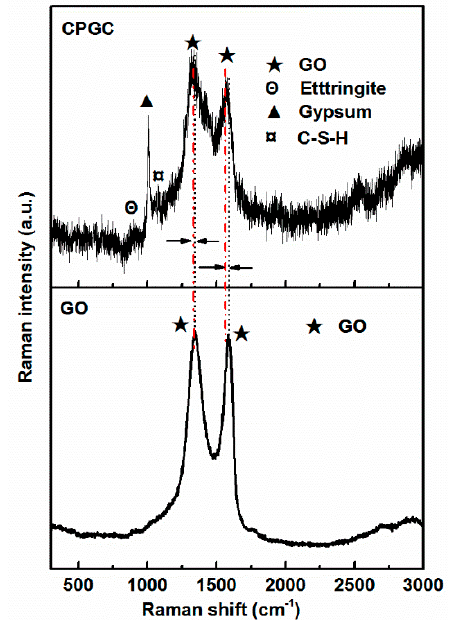
Figure 10. Raman spectrum of the CPGC and GO.